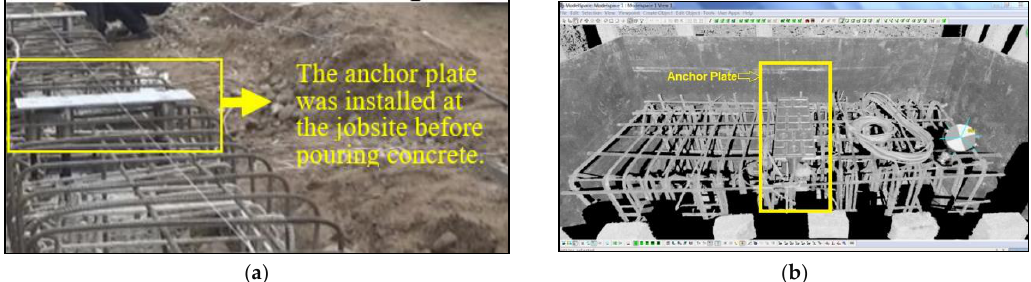
Figure 13. Anchor plate in the job site and point cloud. ( a ) Anchor plate in the job site and ( b ) anchor plate point cloud.